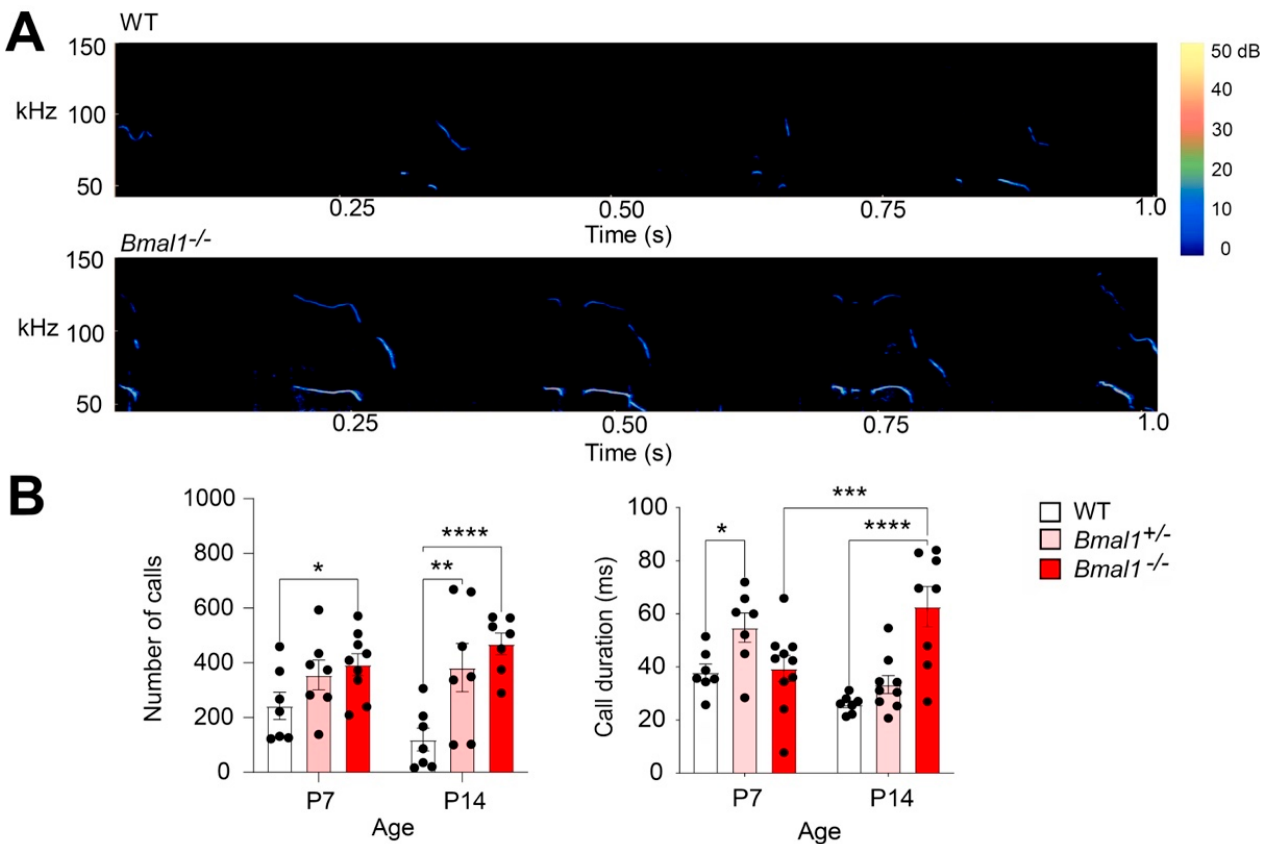
Figure 2. Impaired social communication by ultrasonic vocalizations (USVs) in Bmal1 +/ − and Bmal1 − / − pups. ( A ) Typical sonograms of USVs from a WT and a Bmal1 − / − pup at P7. ( B ) Bar graphs indicating the number of calls and mean call duration of USVs over a 5-min period in pups at P7 and P14. Note that the number of calls was decreased at P14 compared to at P7 in the WT but not the Bmal1 − / − and Bmal1 +/ − pups (F (1, 38) = 0.02423, p = 0.8771, two-way ANOVA; WT, P7 vs. P14: p =